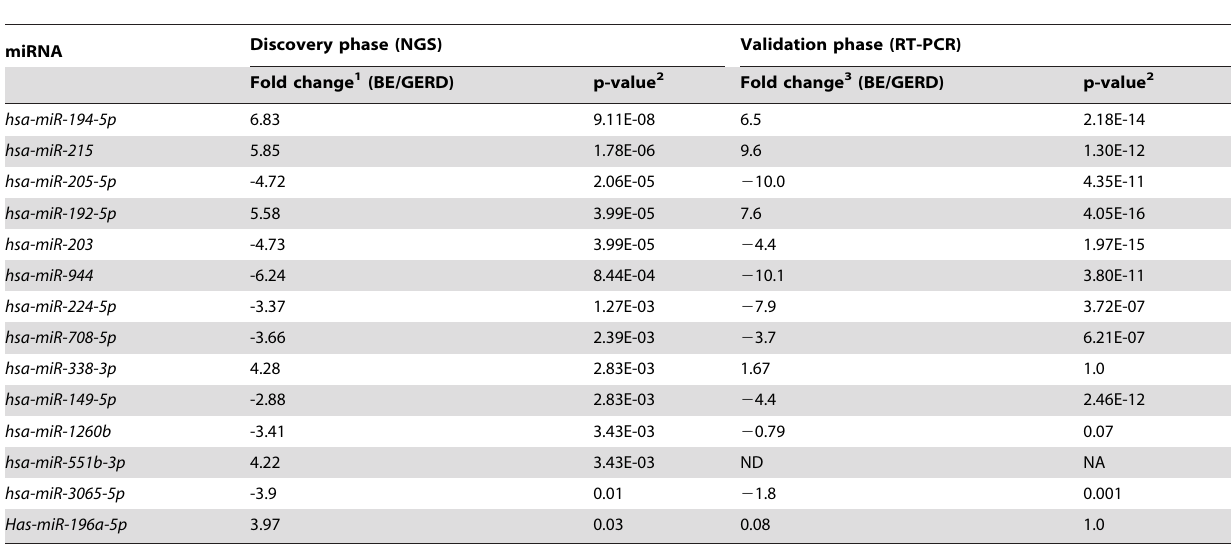
Table 1. Differential expression of miRNA between BE and GERD.